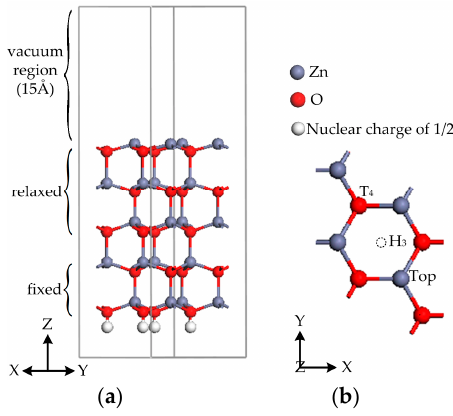
Figure 1. The side view ( a ) and top view ( b ) models of the pristine (2 × 2) ZnO (0001) surface and three adsorption sites. three adsorption